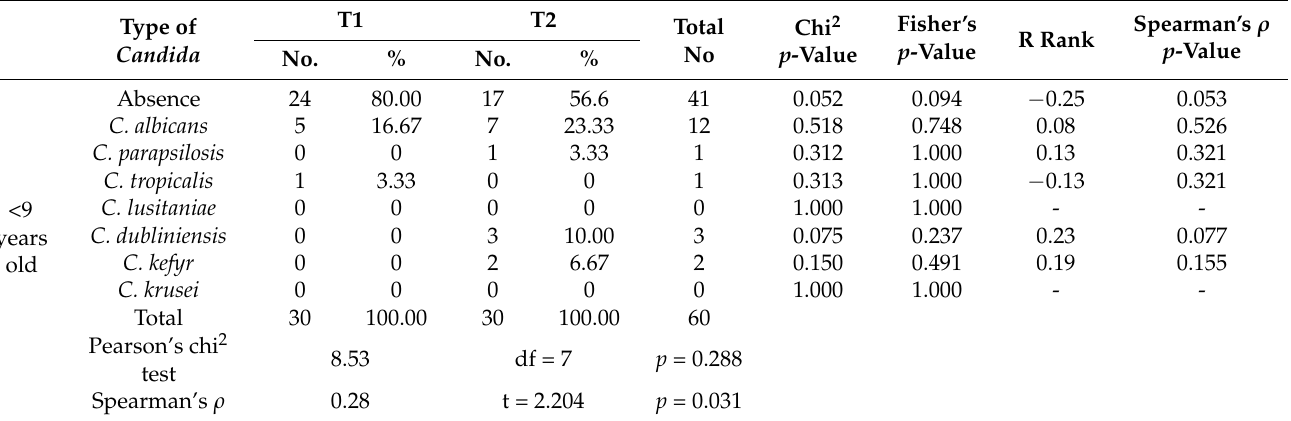
Table 6. Results of the incidence of each fungal species according to the time at which the study was conducted in children in two age